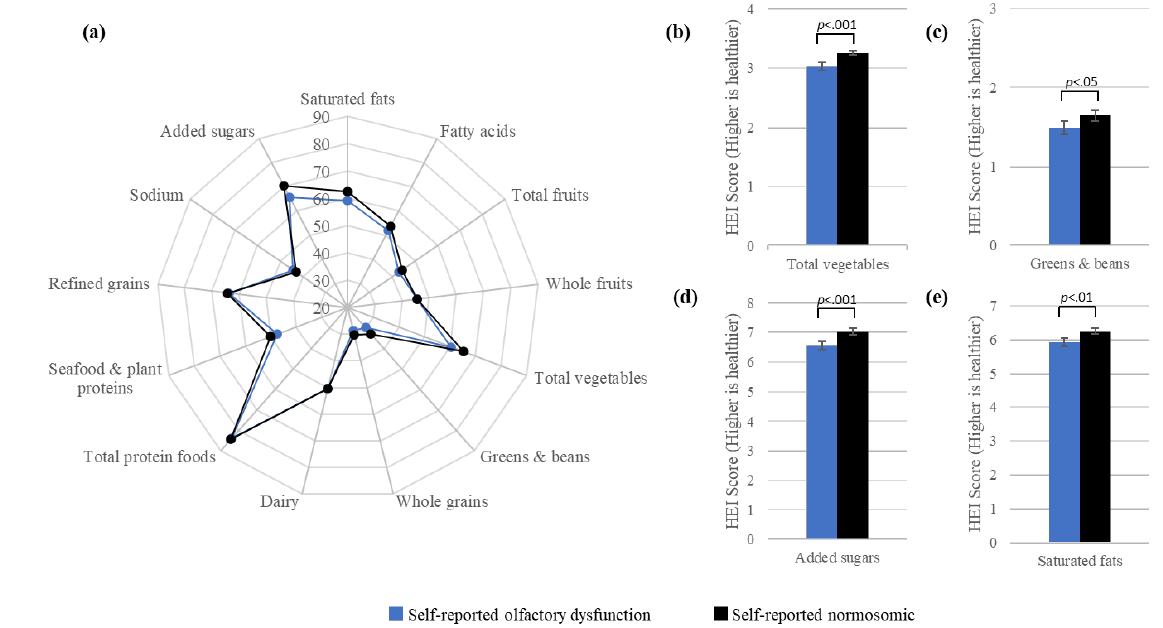
Figure 1. Visualization of the HEI–2015 component scores by olfactory function among NHANES 2011–2014 participants, aged 40 years and older. The radar graph ( a ) displays mean HEI–2015 component scores as a percentage of the maximum component score according to self-reported olfactory function, while the bar graphs ( b–e ) show significant differences in mean component scores by olfactory function for total vegetables ( b ), greens and beans ( c ), added sugars ( d ), and saturated fats ( e ). Lower scores correspond to lower intake for total vegetables ( b ) and greens and beans ( c ), whereas lower scores correspond to higher consumption for added sugars ( d ) and saturated fats ( e ).